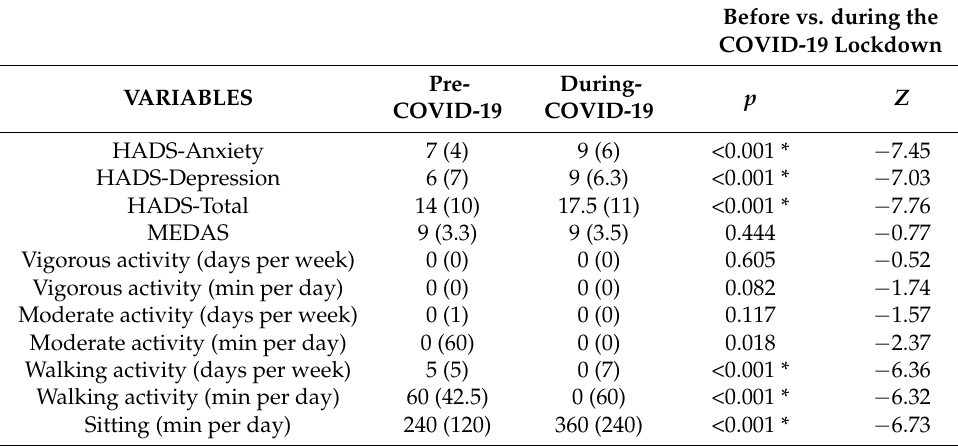
Table 2. Results of the non-parametric Wilcoxon signed-rank tests.